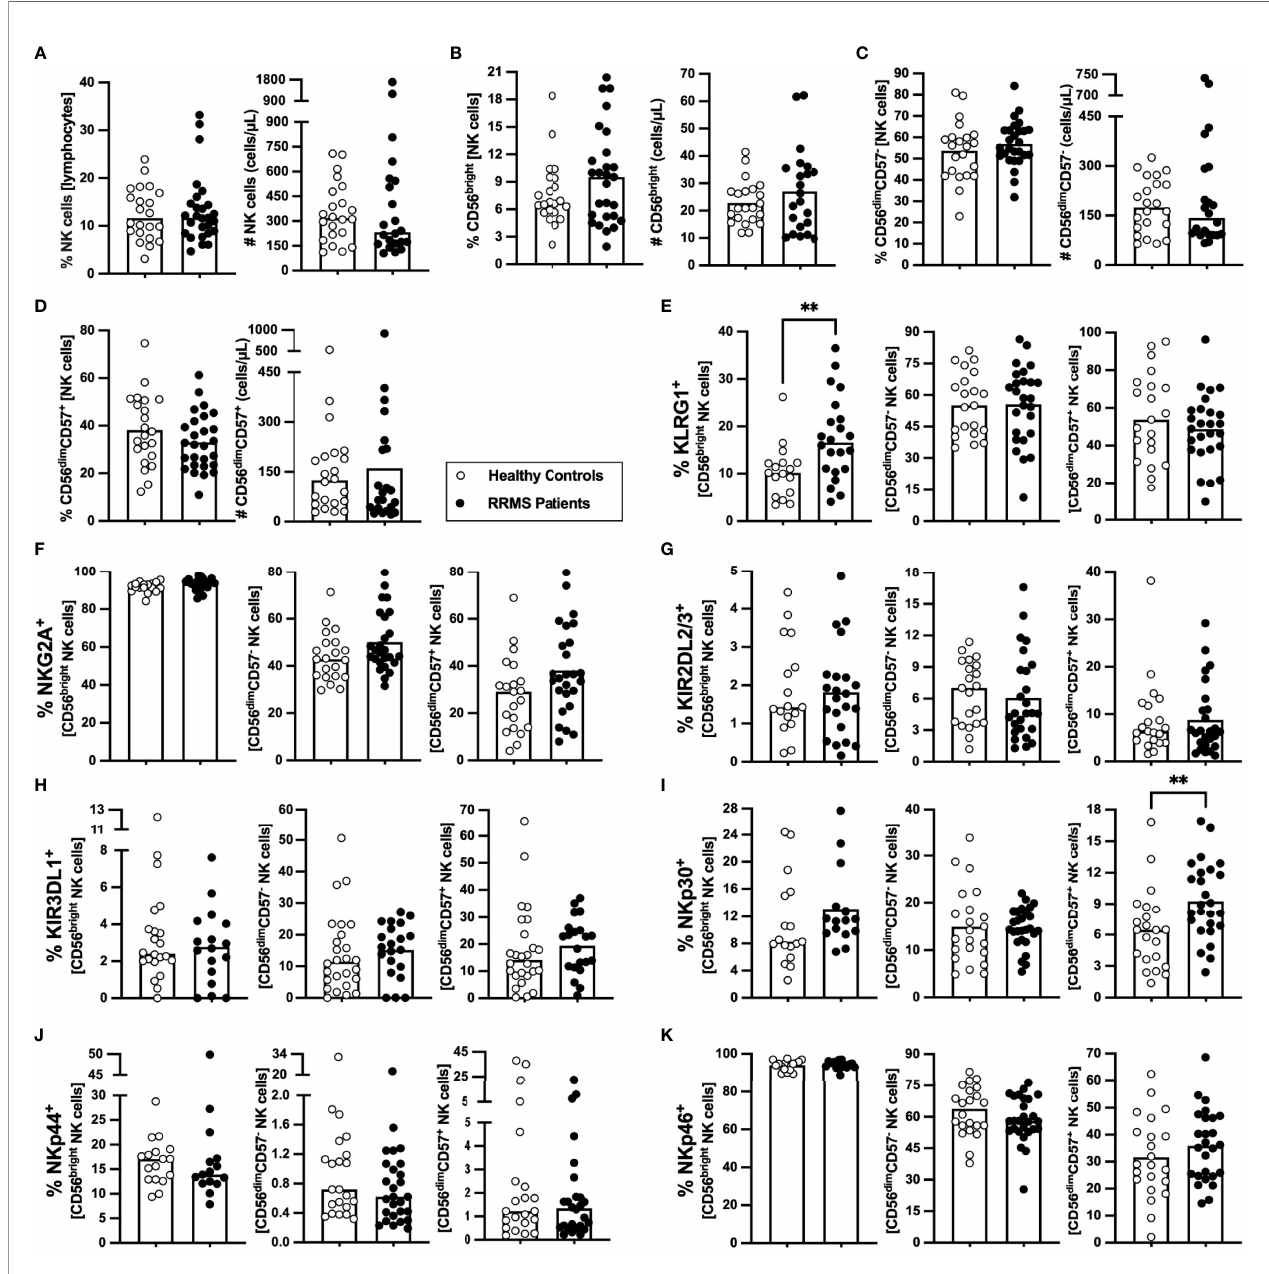
FIGURE 5 | Newly diagnosed RRMS patients have higher percentages of CD56 bright NK cells expressing KLRG1, and CD56 dim CD57 + expressing NKp30. Percentages and numbers of NK are represented for healthy controls (white circles) and newly diagnosed RRMS patients [black circles; (A) ]. Percentages and numbers of NK cells subpopulations: CD56 bright [most immature; (B) ]; CD56 dim CD57 − (C) ; and CD56 dim CD57 + (most differentiated; (D) ). Percentage of cells expressing inhibitory receptors in the three NK cells subsets: KLRG1 (E) , NKG2A (F) , KIR2DL2/3 (G) and KIR3DL1 (H) . Percentage of cells expressing activating receptors in the three NK cells subsets: NKp30 (I) , NKp44 (J) , and NKp46 (K) . The parametric Student ’ s t- test was performed in (B ; number), ( C, D ; percentage), (E ; CD56 dim CD57 − and CD56 dim CD57 + ), (F ; CD56 dim CD57 − and CD56 dim CD57 + ), (G ; CD56 bright and CD56 dim CD57 − ), I ; CD56 dim CD57 − ), and K ; CD56 bright and CD56 dim CD57 + ); the non-parametric Mann – Whitney U - test in (A) , ( B ; percentage), ( C, D ; number), (E) ; CD56 bright ), (F) ; CD56 bright ), (G) ; CD56 dim CD57 + ), (H) , ( I ; CD56 bright and CD56 dim CD57 + ), (J) , and ( K ; CD56dimCD57 - ). Statistical outputs and effect size calculations in eTable 1 . In all graphs, each dot represents one individual, and the horizontal lines the groups ’ means or medians depending on the normal or non-normal distribution of the data, respectively. When differences were statistically signi fi cant ( p-value < 0.050), the p -value was represented by ** 0.001< p ≤ 0.010. Results are maintained upon controlling for sex, age, and human cytomegalovirus IgG seroprevalence on multiple linear regression models ( eTable 8